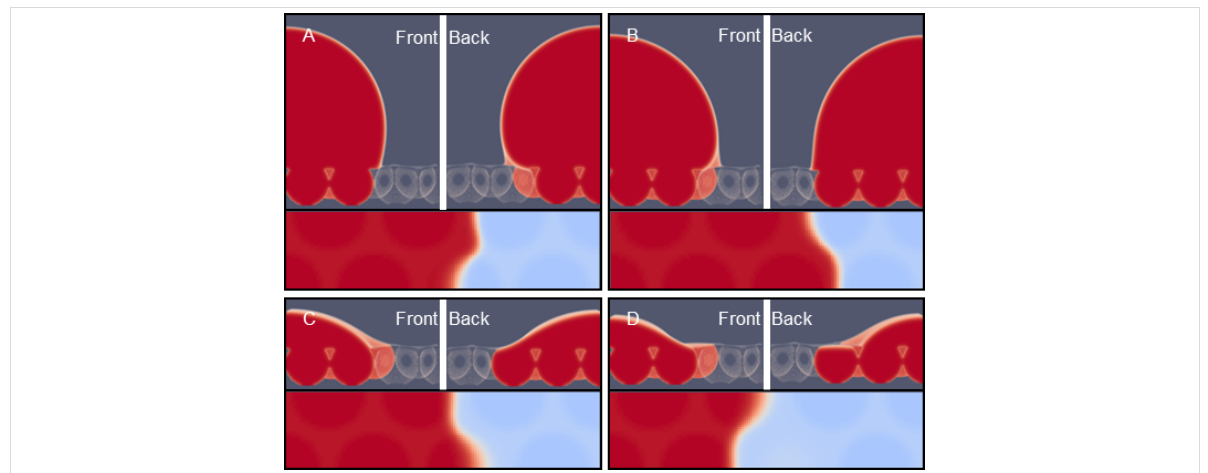
Figure 8: Four examples of droplets on an inverse opal with d = 31, s = 30, c = 0.80, n = 3.5, and χ S = − 0.3. A,B) Two advancing water fronts with rel- atively high contact angles; C,D) two receding water fronts with low contact angles. For each panel the left ( z , + y ), right ( z , − y ) and bottom images ( x , y ) are for different view-points, that is, the left image is taken from the front, the right image is taken from the back, the bottom image is the top-view. Colour coding: Red is high-density liquid. Blue is low-density gas. White is intermediate density. The snapshots are taken from the calculations of Figure